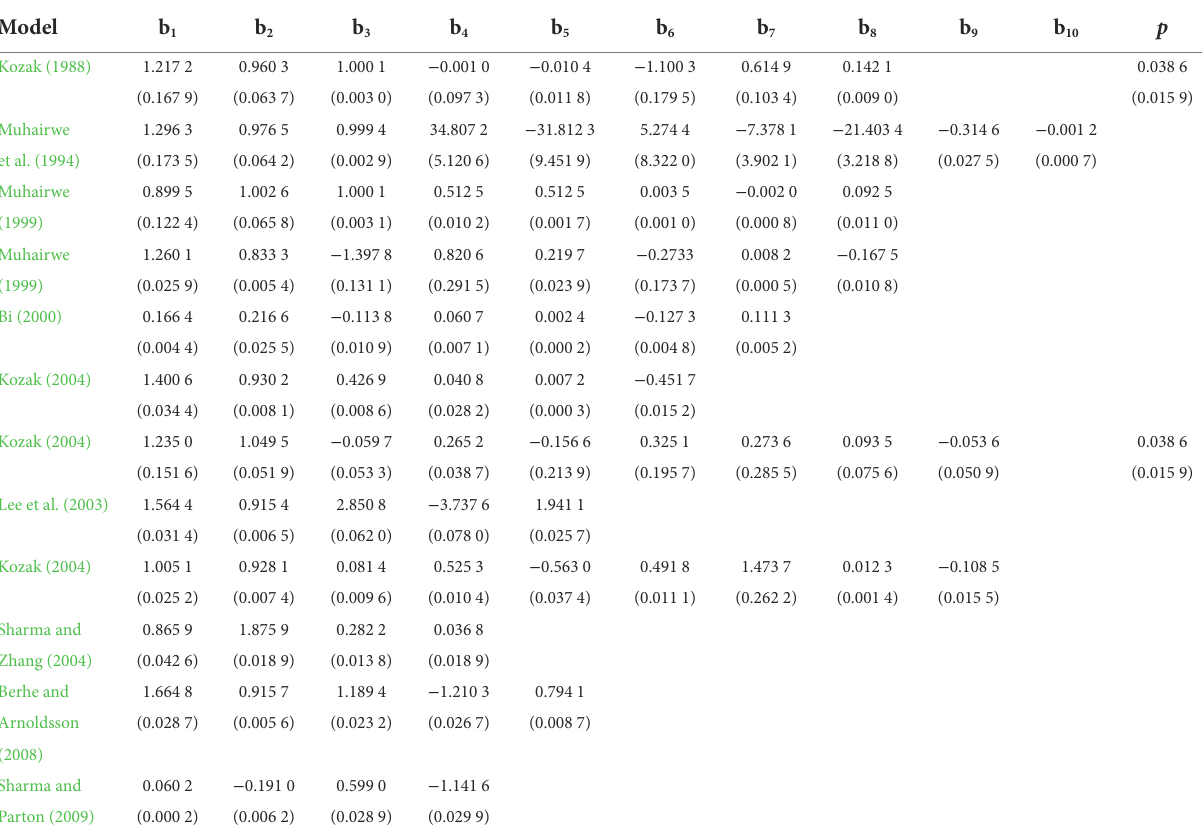
TABLE 3 Parameter estimates with approximate standard errors for 12 selected basic models.